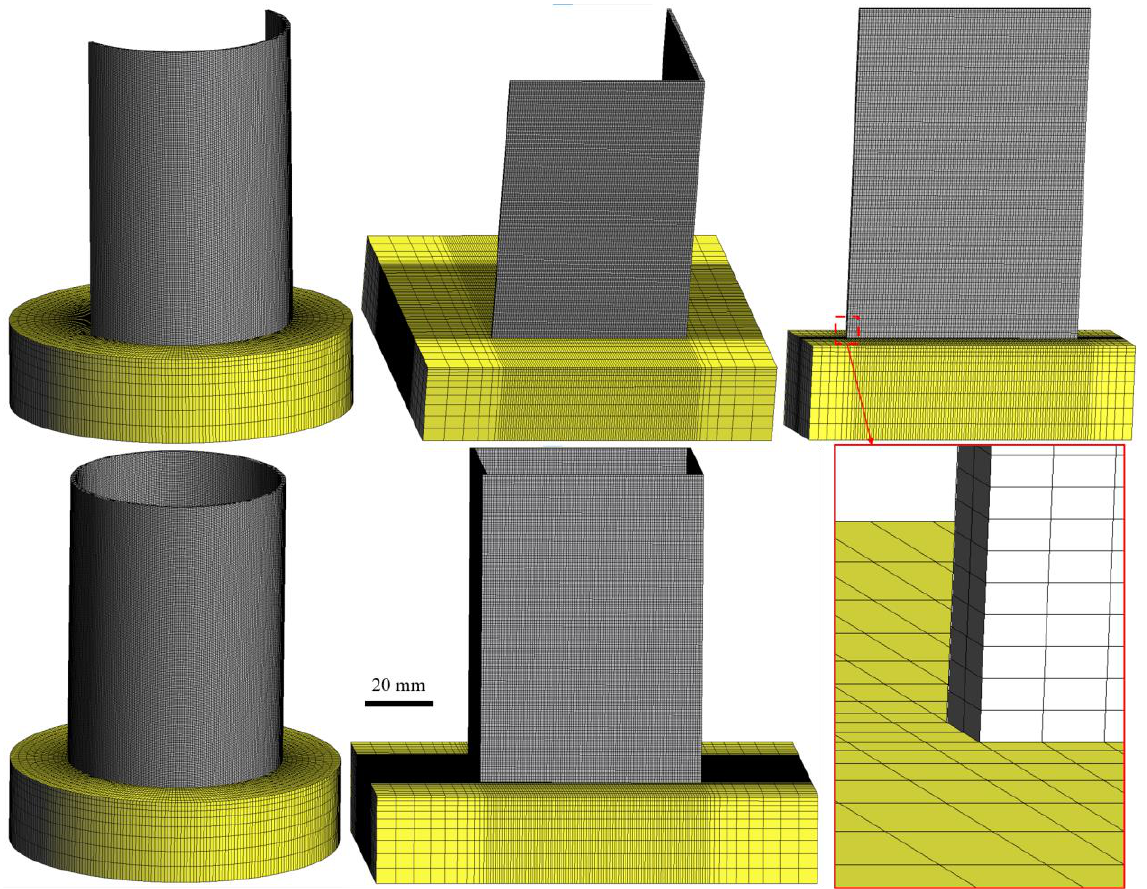
Figure 3. 3D FE mesh models of different thin-walled structures.